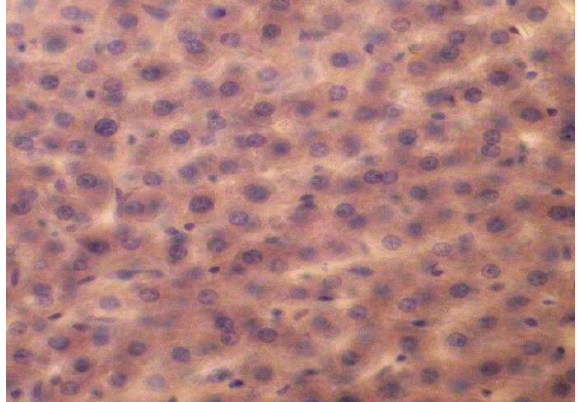
Fig. 2. Liver of intact rat. Absence of fat in the cytoplasm of hepatocytes frozen transection, Sudan ΙV. ×250 Sinusoidal hemocapillars are unevenly enlarged, cities are full-blooded. Hepatocytes and their nuclei vary somewhat in size. Cell nuclei were slightly hyper- chromic, nucleoli differed not clearly. Kupffer cells were activated in cites. Vacuolation of cytoplasm of hepato- cytes was diffusely or large focal part of the